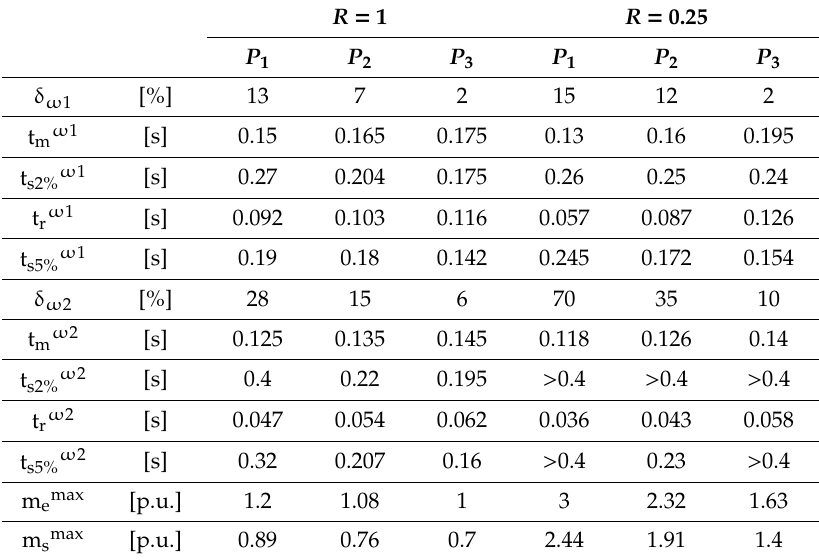
Table 1. Characteristic values of the transients for system with R = 1 and R = 0.25. R = 1 R =